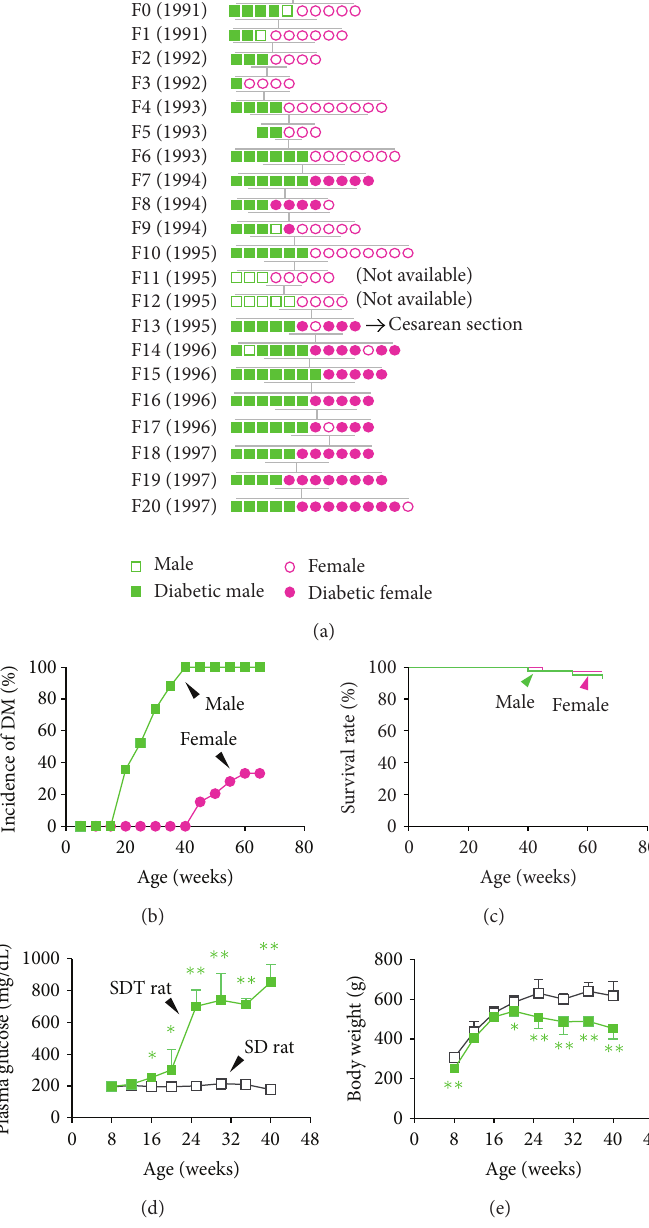
F 2: �edigree maps and general pro�les of SDT rats. �edigree maps of nucleus line (a) and basic pro�les of SDT rats. e cumulative incidence of DM was 100 at 40 weeks in male SDT rats (b) and the survival rates at 65 weeks was over 90 in male SDT rats reached 700mg/dL by 25 weeks (d) and a decrease in body weight was observed from 20 weeks (e). Green square: male SDT rats, pink circle: female SDT rats. Open symbols represent male or female SD rats. Data represent means % (versus age-matched SD rats, unpaired t -test). Figures are modi�ed from [4, ∗∗ 𝑃𝑃 𝑃 𝑃𝑃𝑃𝑃